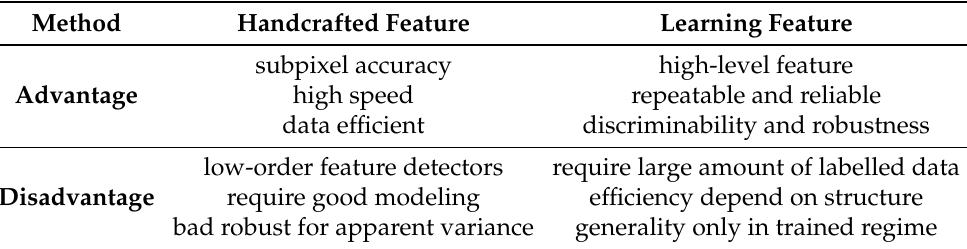
Table 1. The main properties of handcrafted-based methods and learning-based